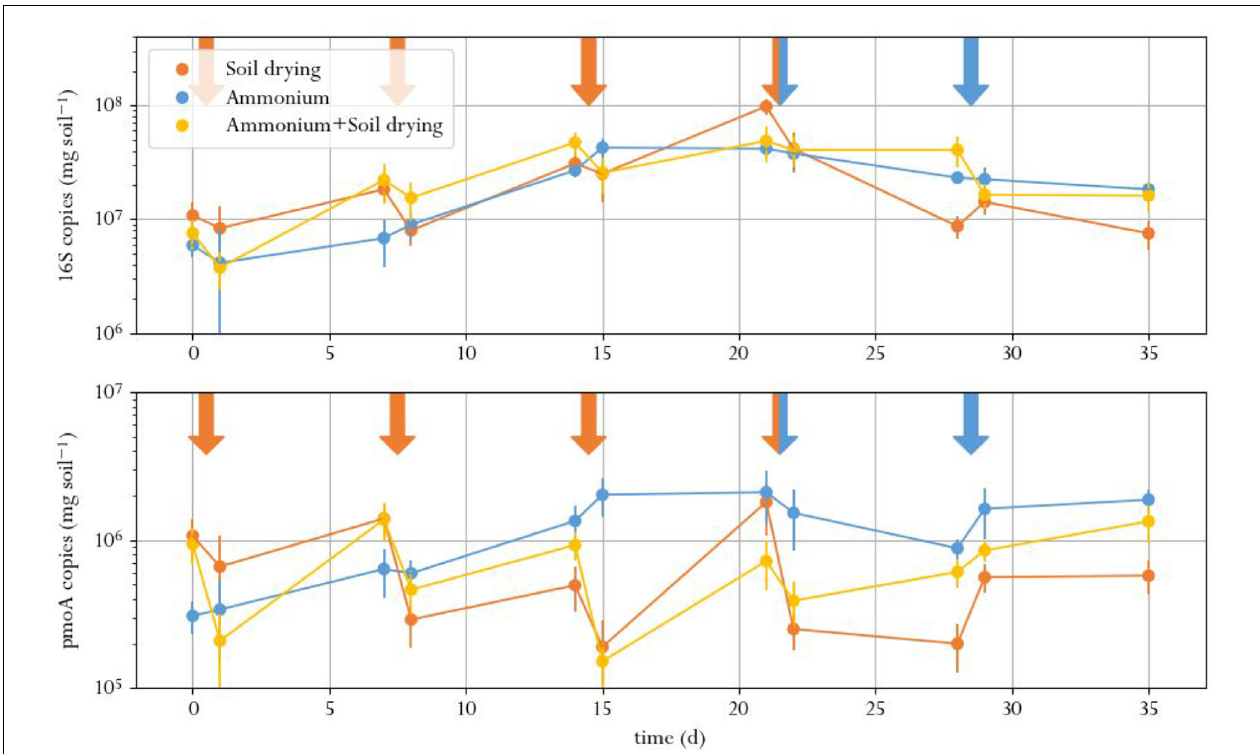
FIGURE 3 | Total amount of 16S (top) and pmoA (bottom) copies in soil microcosms, exposed to different perturbation regimes. Orange arrows indicate soil drying events, blue arrows indicate ammonium addition to the corresponding treatment. Error bars represent standard error of the